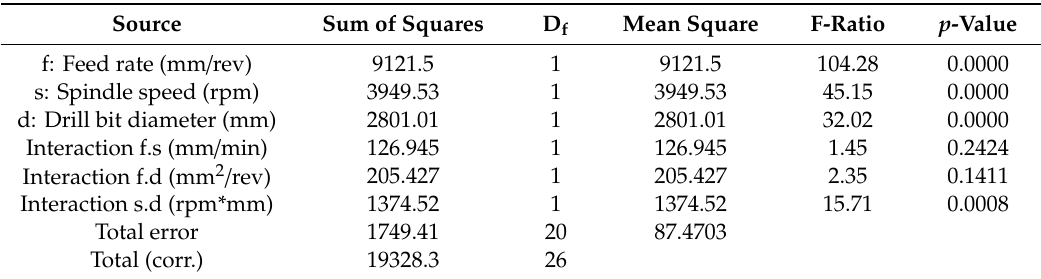
Table 4. ANOVA for thrust